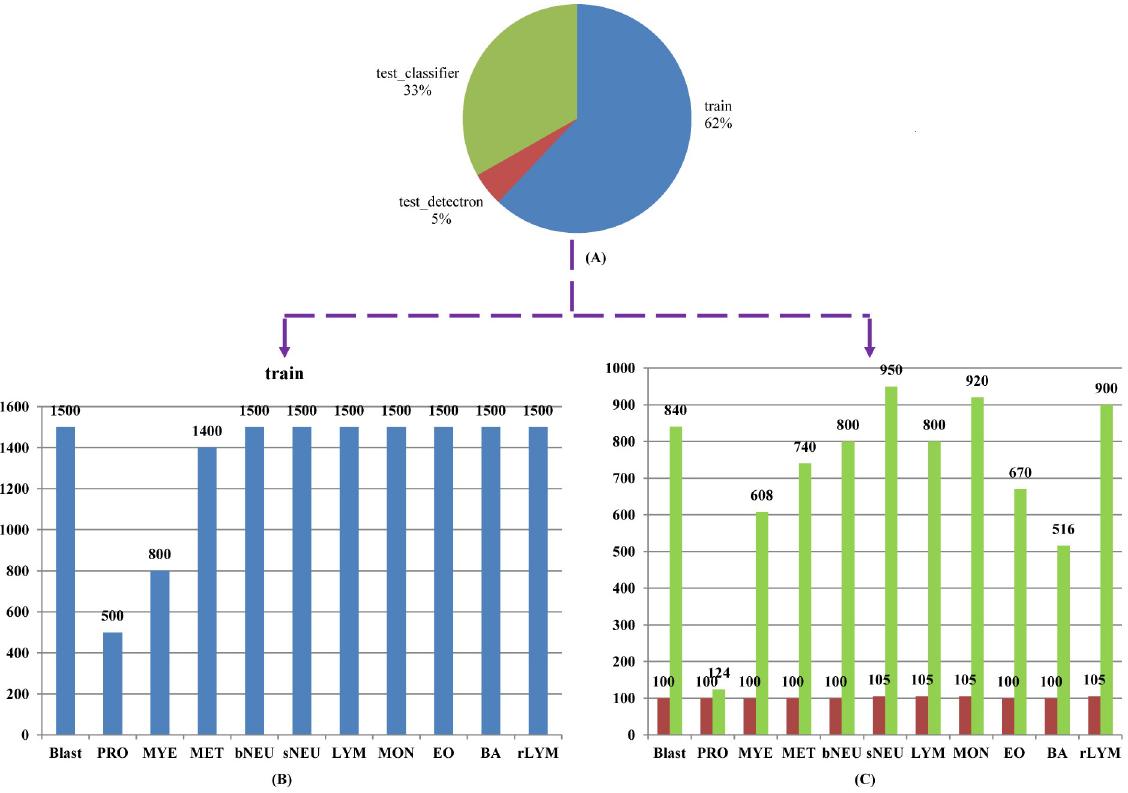
Fig 3. Dataset organization and categories distribution. (A) proportion of train/detection test/classification test sets; (B) train set (14700images, 11 types of peripheral leukocytes) distribution; (C) detection test set (reddish-brown chart, 1120 images) and classification test set (green chart, 7868 images)